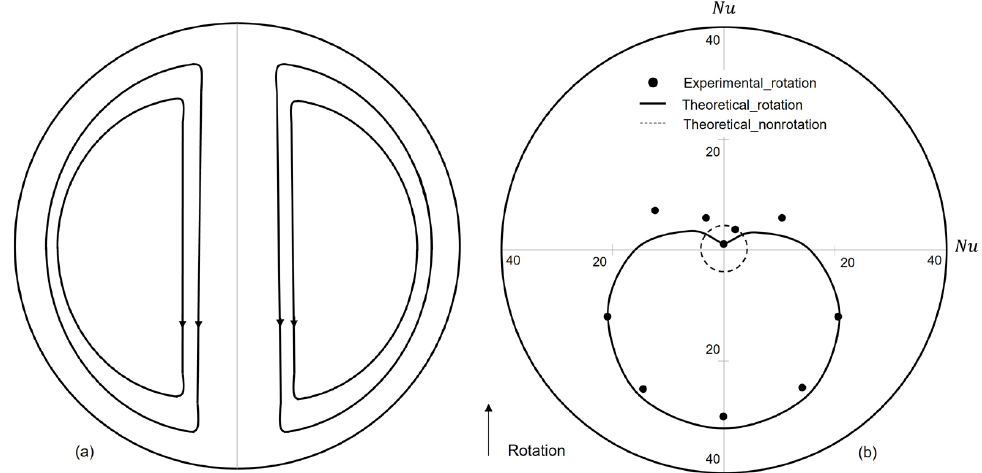
Figure 11. ( a ) Schematic illustration of cross-stream secondary flow; ( b ) local analogous Nusselt number in laminar regime ( Re 2200, wall temperature 314.4 K, air temperature 302 K, rotational speed 920 rpm; data from [50]).